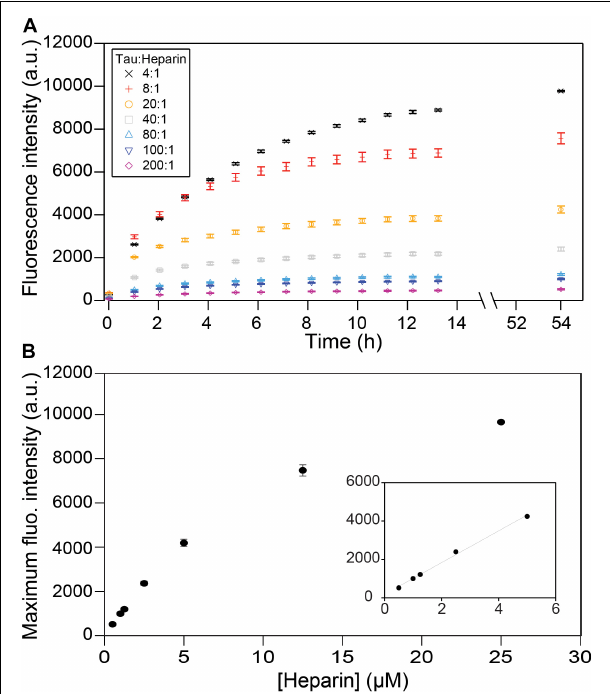
FIGURE 2 | ThT fluorescence measuring β -sheet formation as a function of time and tau:heparin molar ratio. Tau concentration is 100 µ M. Kinetic curves (A) have plateaued after 53 h and the fluorescence intensities at this time are reported as a function of heparin concentration (B) . A zoom at low heparin concentration ( B , inset) shows a linear behavior. Gaps between 13 and 54 h represent reading interruptions. Error bars represent standard deviation over 3 repeats.